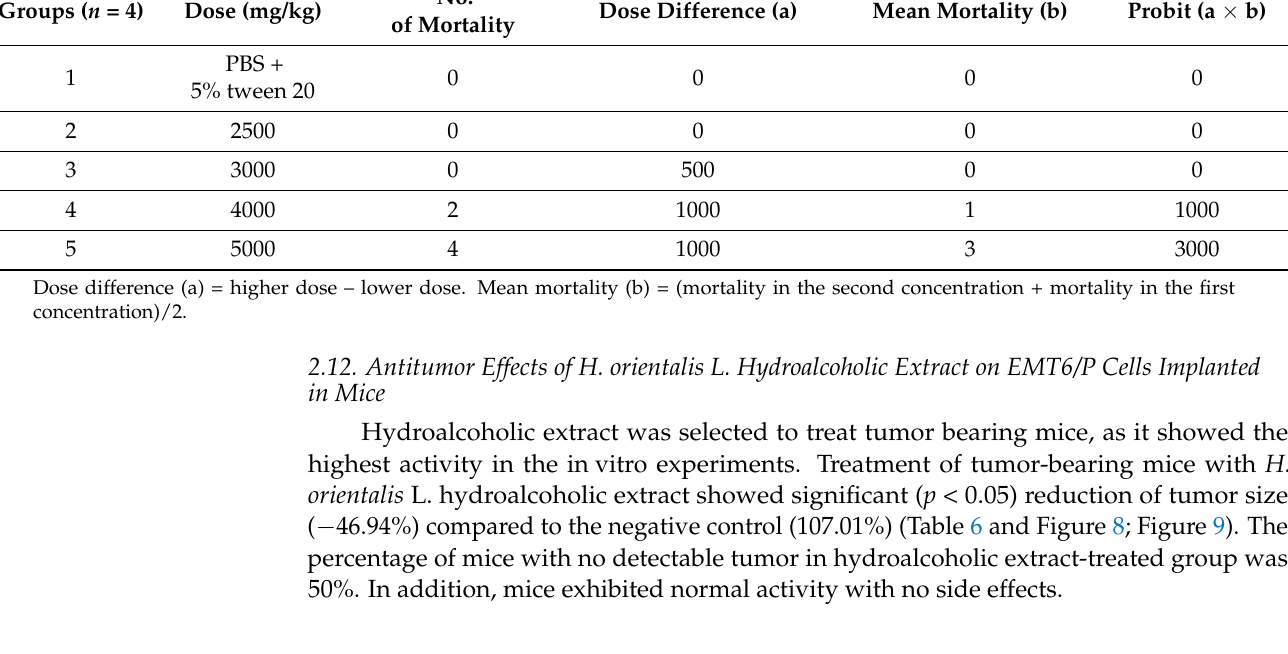
Table 5. Acute toxicity assay of H. orientalis L. hydroalcoholic extract in mice ( n = 4) injected intraperitoneally and observed for 24 h. n = number of mice in each group. Groups ( n =